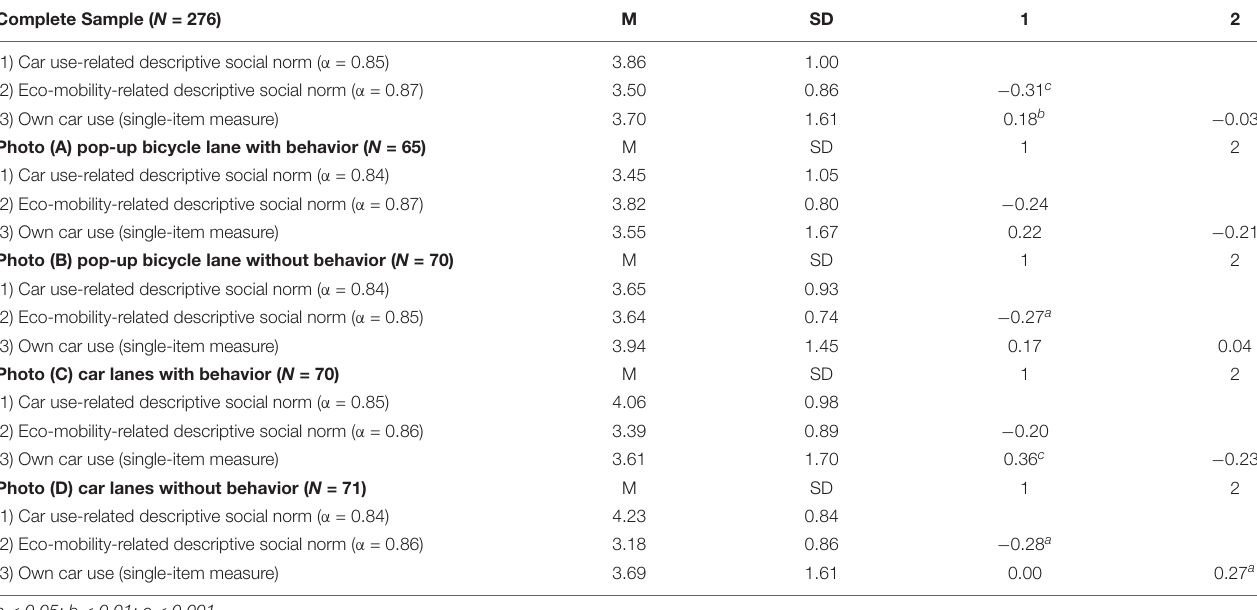
TABLE 4 | (Study 3) Labels, Cronbach’s α , means, SDs and correlations of the descriptive norms and individual mobility behavior mean value indices ( N = 276). Complete Sample ( N = 276)